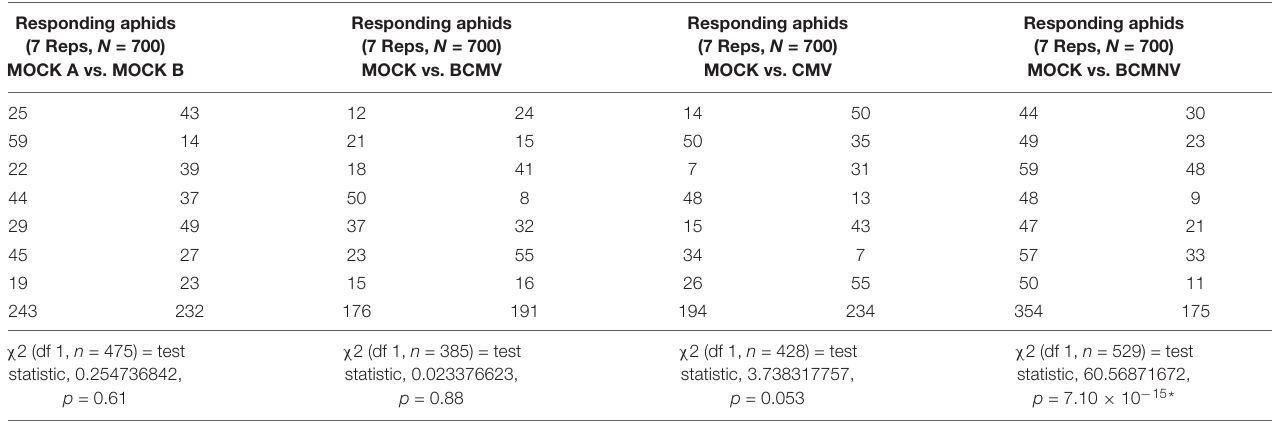
TABLE 3 | Olfactometry test with Aphis fabae over 24 h. Responding aphids (7 Reps, N =